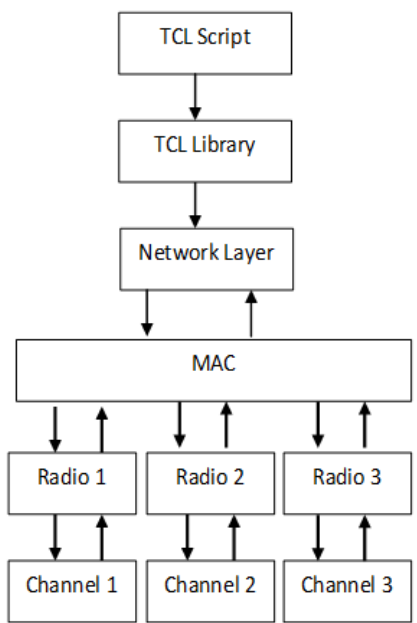
Figure 1. Design overview for multi-channel